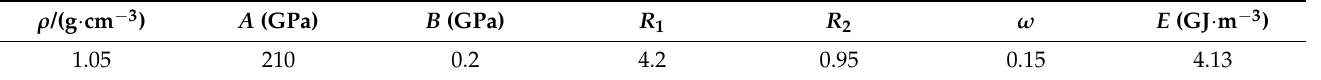
Table 4. Parameters of high-energy explosive